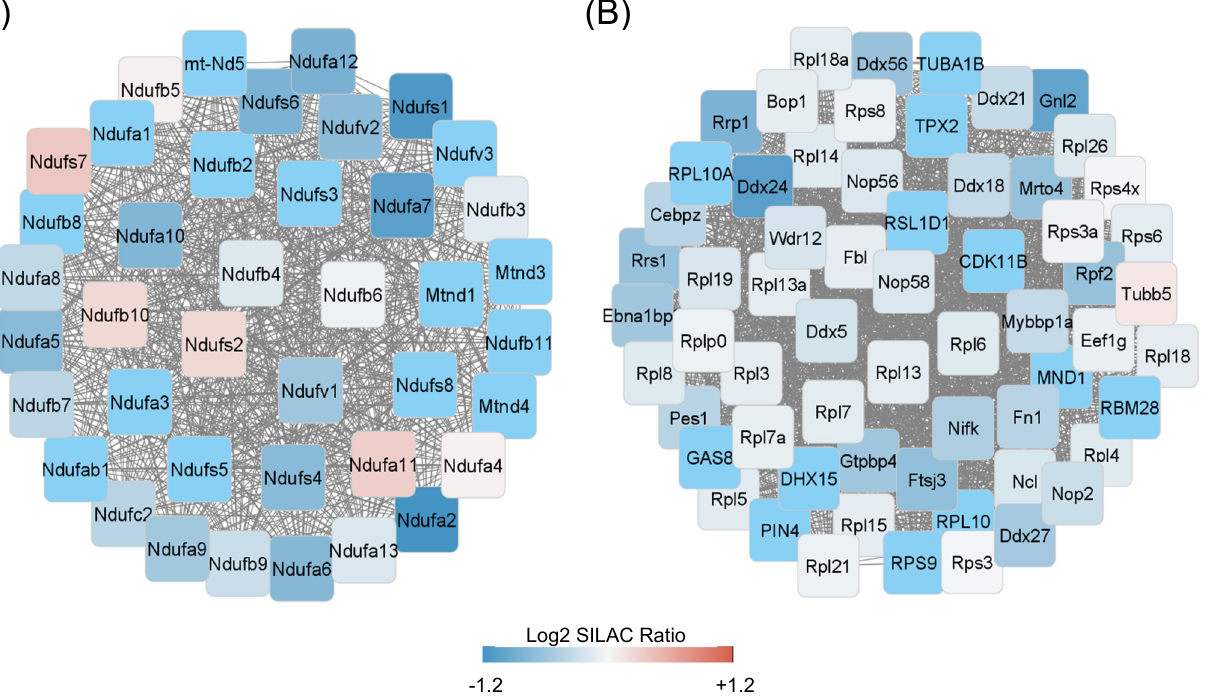
Figure 4. A schematic representation of protein complex interaction networks. Chronic iron deficiency treatment of HT22 cells significantly downregulated mitochondrial respiration chain complex I ( A ) and Parvulin-associated pre-RNP complex ( B ). The node color represented the log2 SILAC ratio of treatment (heavy labeling) vs. control (light labeling).